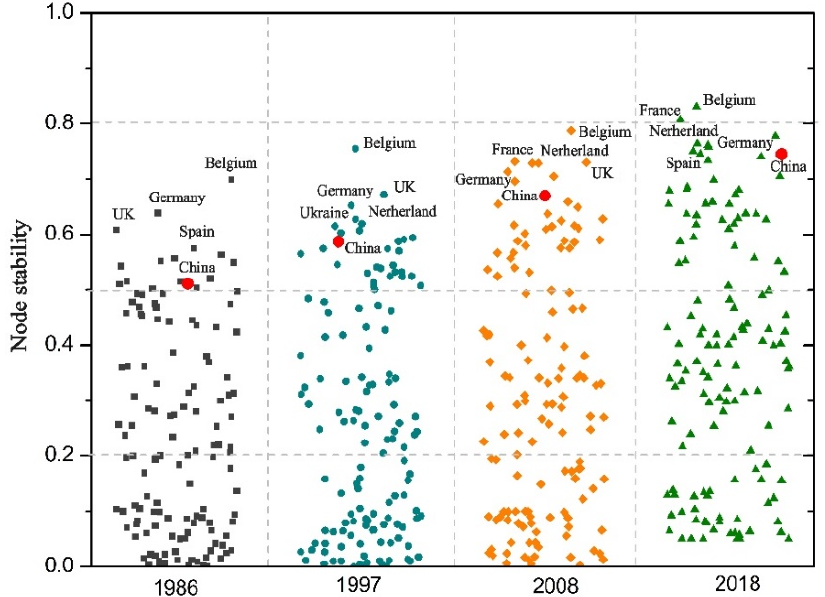
Figure 3. The nodes’ stability changes in the global ATN in the four stages.